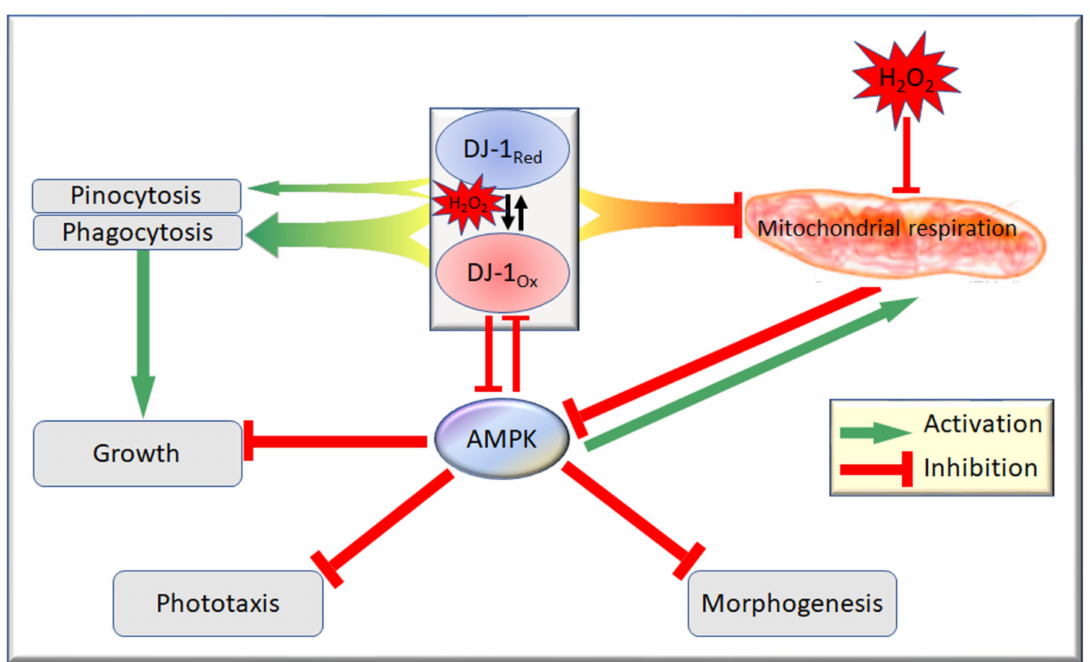
Figure 9. Model for phenotypic consequences of interactions between DJ-1, AMPK, mitochondrial respiration and oxidative stress. Mitochondrial respiration is inhibited separately by oxidative stress and DJ-1, both in its oxidized (DJ-1 Ox ) and reduced (DJ-1 Red ) states (indicated by the bifurcated base of the arrow). DJ-1 also activates phagocytosis (broad arrow) and, to a slight extent, (narrower arrow) pinocytosis, regardless of its oxidation state (indicated by the bifurcated base of the arrows). DJ-1 Ox , but not DJ-1 Red , inhibits and is inhibited by AMPK. Under oxidative stress, mitochondrial respiration is inhibited, ATP production is compromised and AMPK is activated. At the same time, DJ-1 is oxidized and inhibits AMPK, opposing the effects of impaired respiration and protecting cells from the downstream phenotypic consequences of chronic AMPK